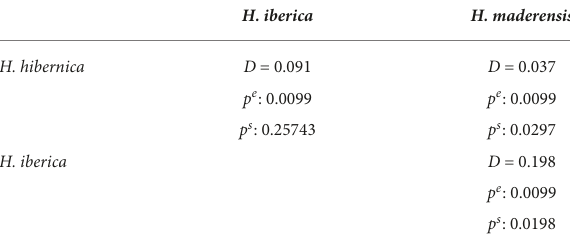
TABLE 1 Pairwise climatic niche overlap statistics of the western polyploid clade of Hedera